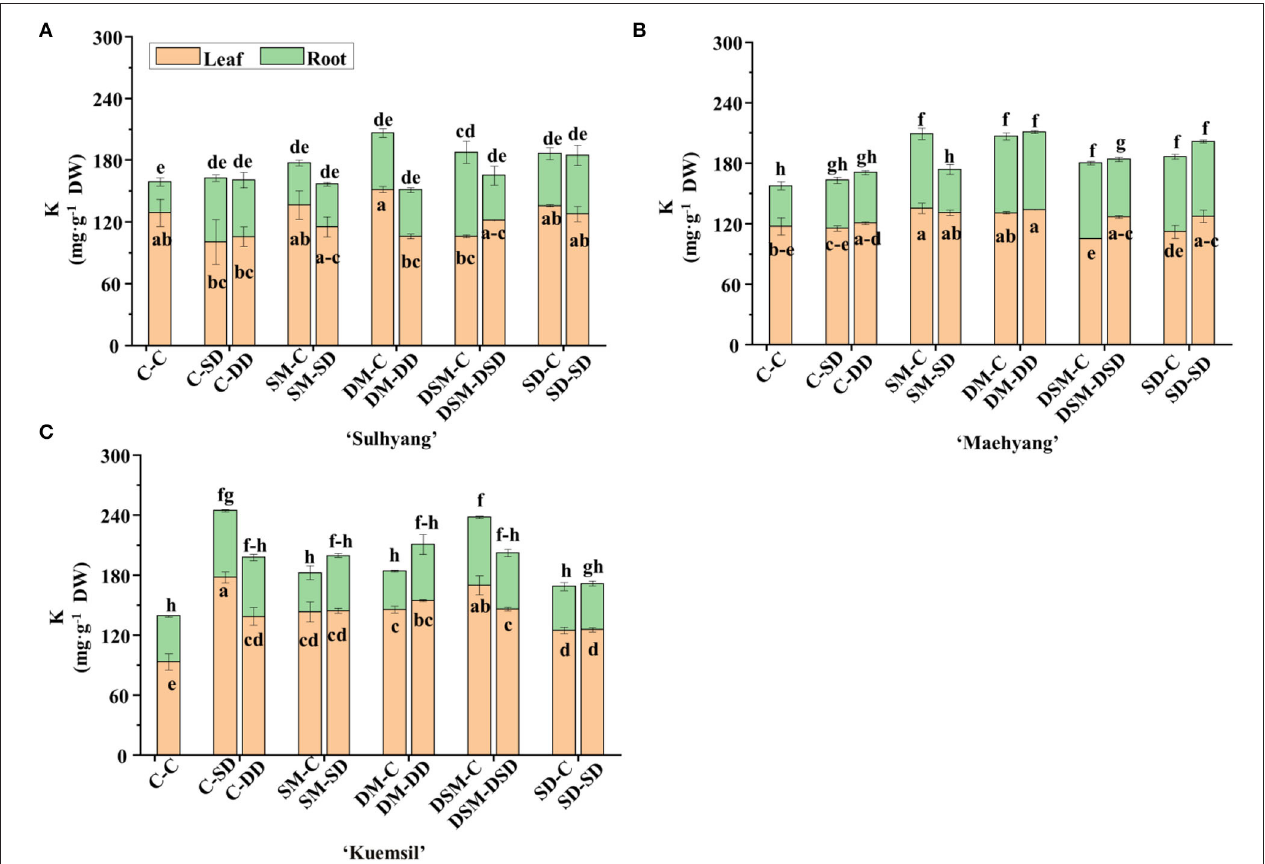
FIGURE 9 | The K content in leaves and root of strawberry transplants (A) “Sulhyang”; (B) “Maehyang”; and (C) “Kuemsil” as affected by the Si treatments subjected to 43 ◦ C for 7 days. Lowercase letters indicate significant differences calculated by the Duncan’s multiple range test at p ≤ 0.05. See Figure 1 for descriptions of treatment